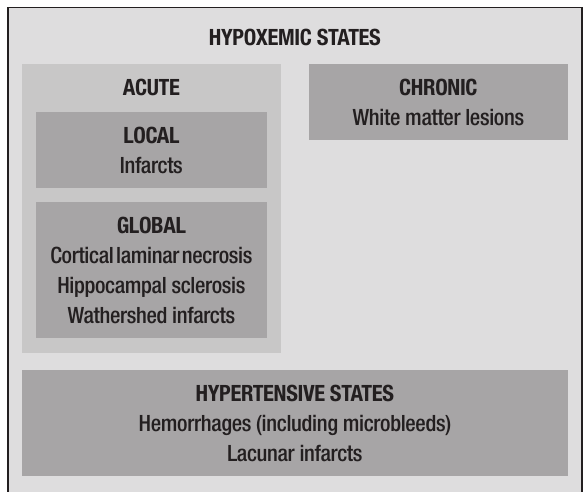
Figure 3. Suggested pathogenesis-based classification for cerebrovascular